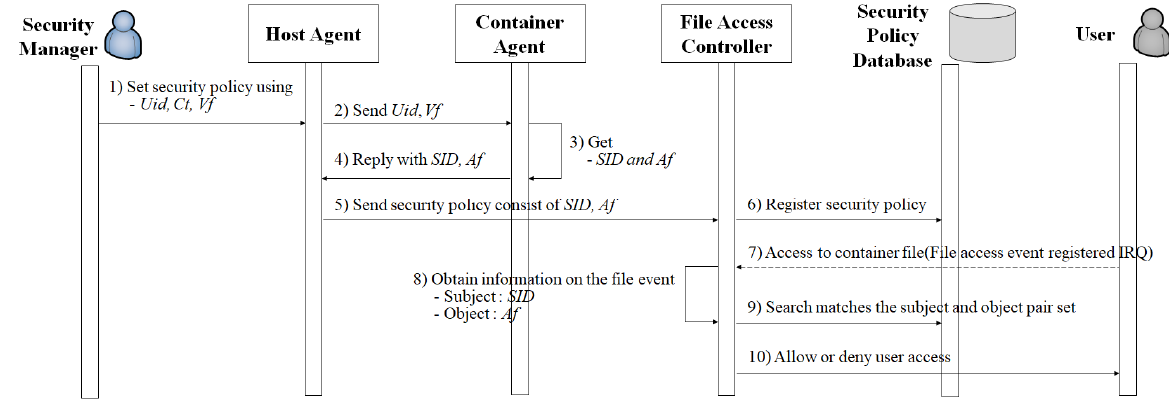
Figure 7. Sequence diagram of providing the container file access control function.